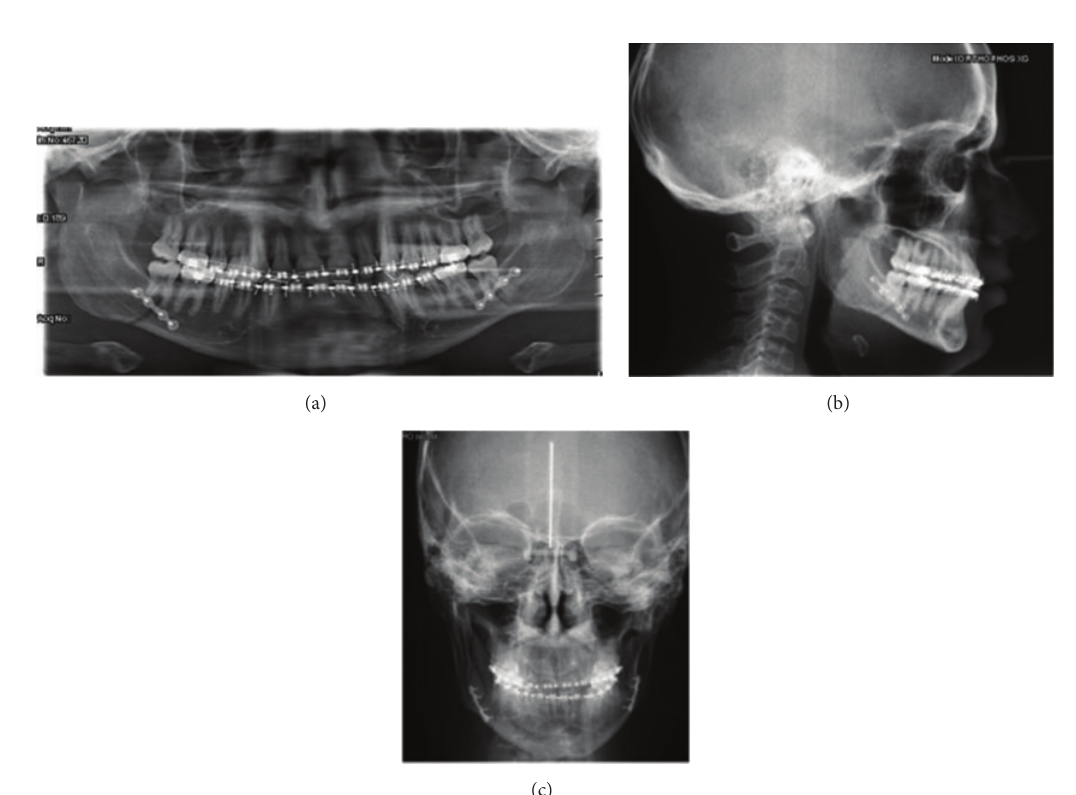
Figure8:Postoperativeradiologicalevaluation.(a)Orthopantomograph;(b)laterolateralteleradiographyoftheskull;and(c)teleradiography of the skull in a posteroanterior